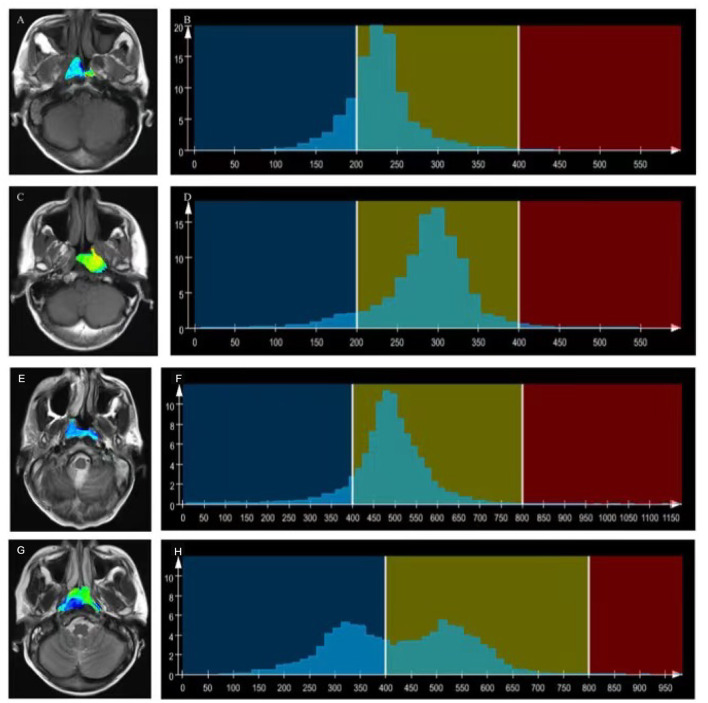
T1WI overlaid with color maps (A,C) and histograms of whole-tumor using T1WI maps (B,D). A T1WI histogram from (A) male patient with EBV DNA NPC showed higher T1WISkewness (T1WISkewness = 0.737). (B) than that of a male patient with EBV DNA-positive NPC (T1WISkewness = 0.435). (D) T2WI) overlaid with color maps (E,G) and histograms of whole-tumor using T2WI maps (F,H). A T2WI histogram from a female patient with EBV DNA-negative NPC showed obviously higher T2WIKurtosis (T2WIKurtosis = 9.004) (F) than that of a male patient with EBV DNA-positive NPC (T2WISkewness = −0.958) (H). T1WI, T1-weighted imaging; EBV, Epstein–Barr virus; NPC, nasopharyngeal carcinoma, T2WI, T2-weighted imaging.